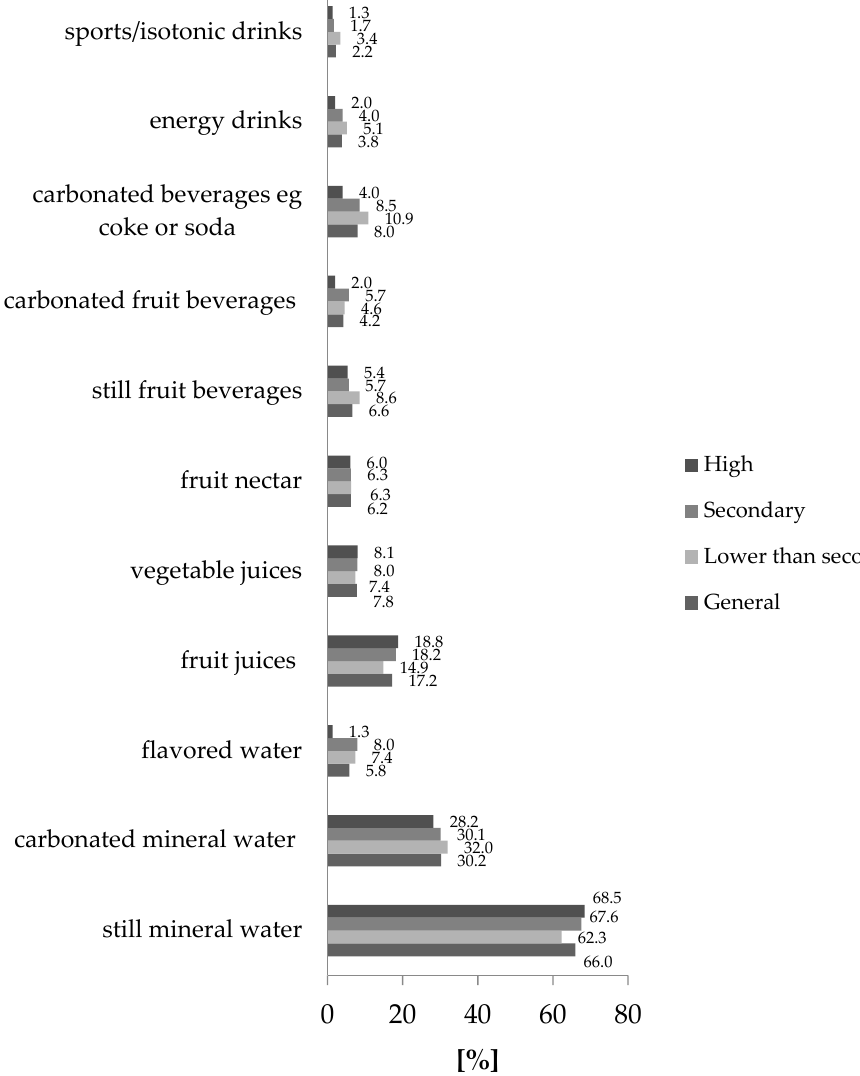
Figure 2. Relationship between drinks consumed on an everyday basis and education.